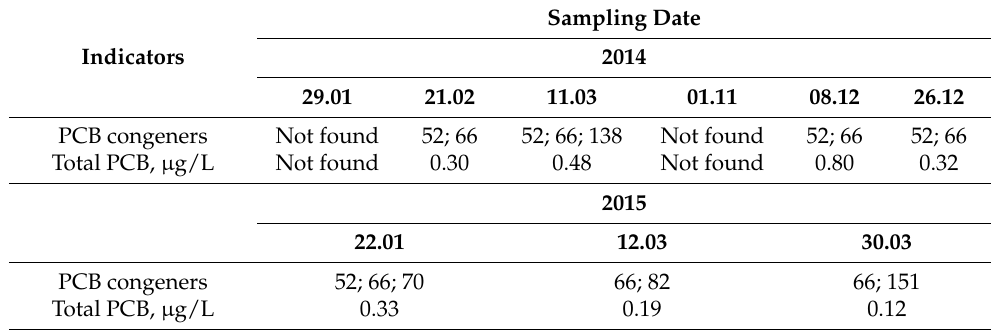
Table 1. Content and congener composition of PCBs in solid precipitation in the territory of Talgar city.